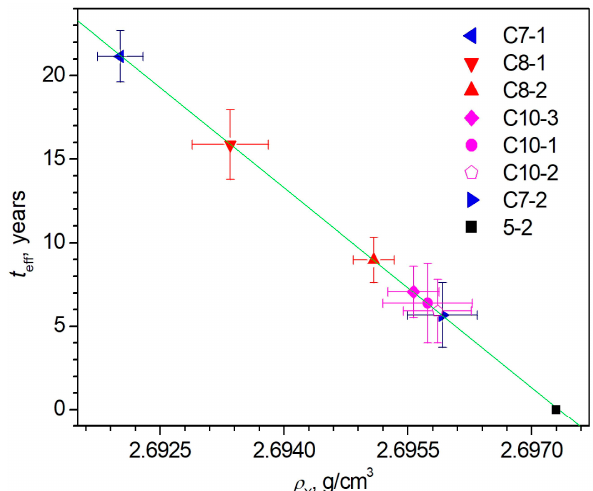
Figure 15. Effective service life t eff of wire samples C7, C8, and C10 after fatigue testing and that of a new sample 5-2 before testing as a function of the density ρ X of the samples, estimated from